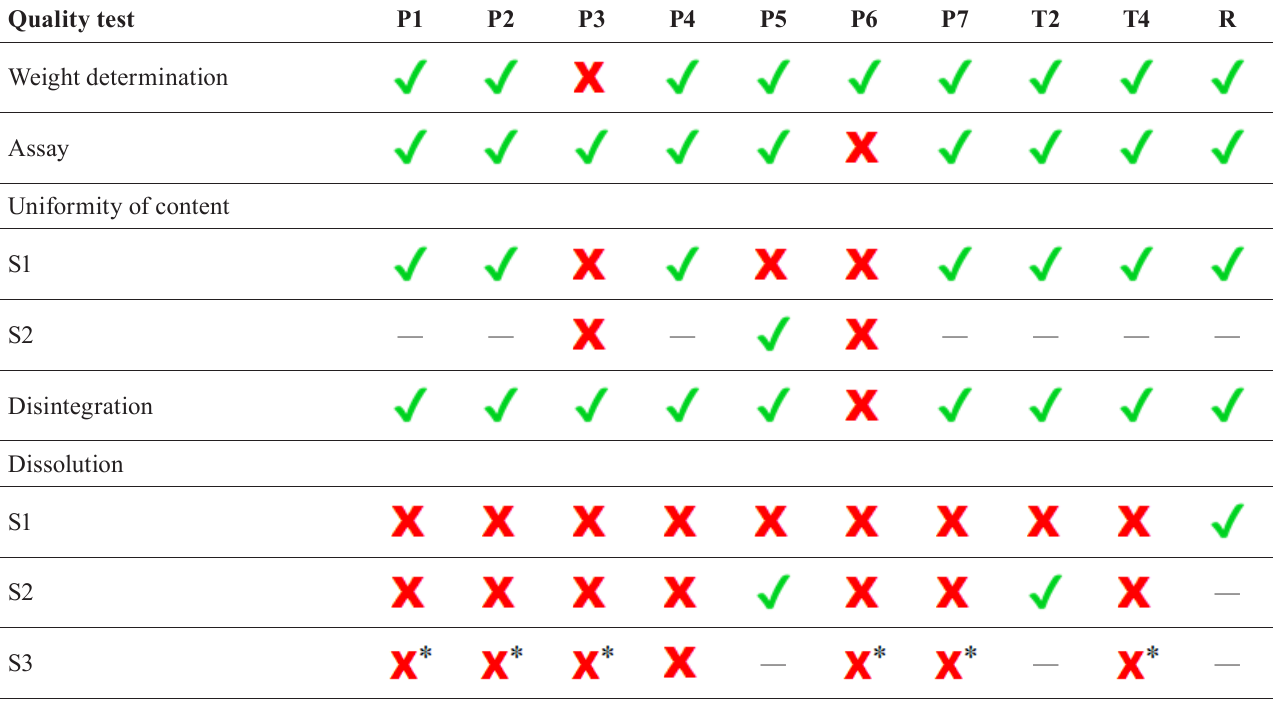
TABLE VII: Summary of approvals and failures for all batches of products analyzed Quality